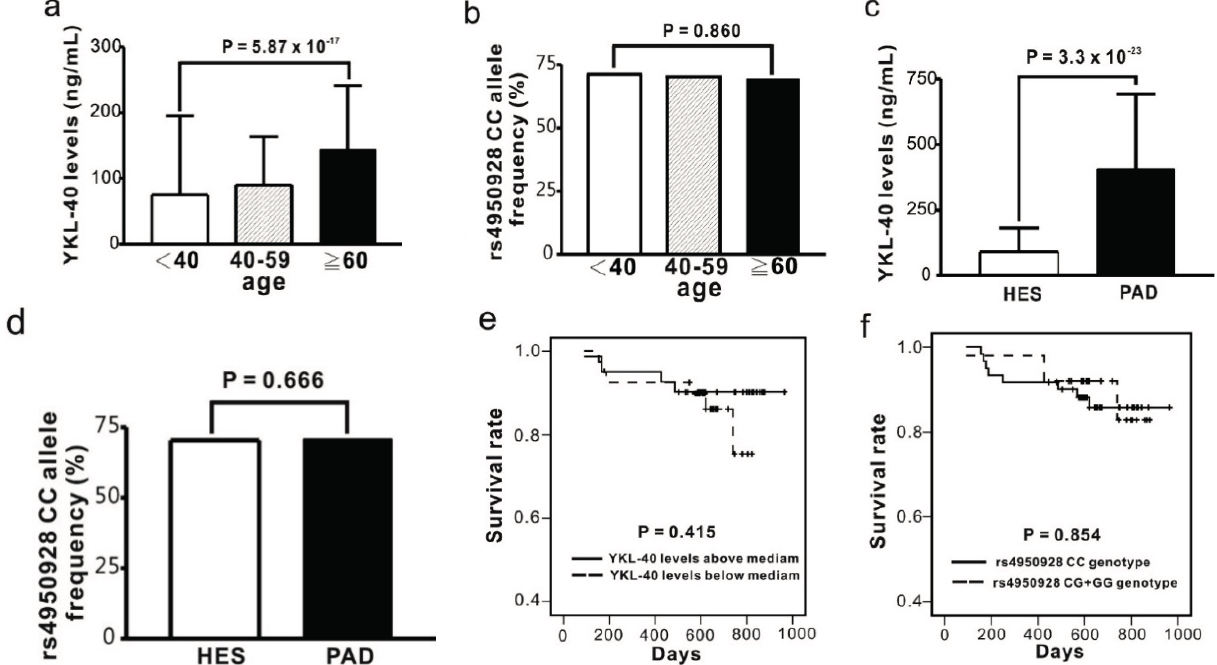
Figure 1. Association of circulating YKL-40 level and CHI3L1 gene variants with age, disease status and long-term outcome of peripheral artery disease (PAD). For health examination subjects (HES), YKL-40 levels ( a ) but not CHI3L2 gene variants ( b ) are significantly associated with age; PAD patients have higher YKL-40 levels compared to HES ( c ); while no significant difference was noted between the two study groups in the CHI3L1 genotype frequencies ( d ); Kaplan-Meier survival curve showed no difference for long-term mortality in PAD patients between subgroups of YKL-40 levels above or below the median ( e ) and between CHI3L1 genotypes ( f